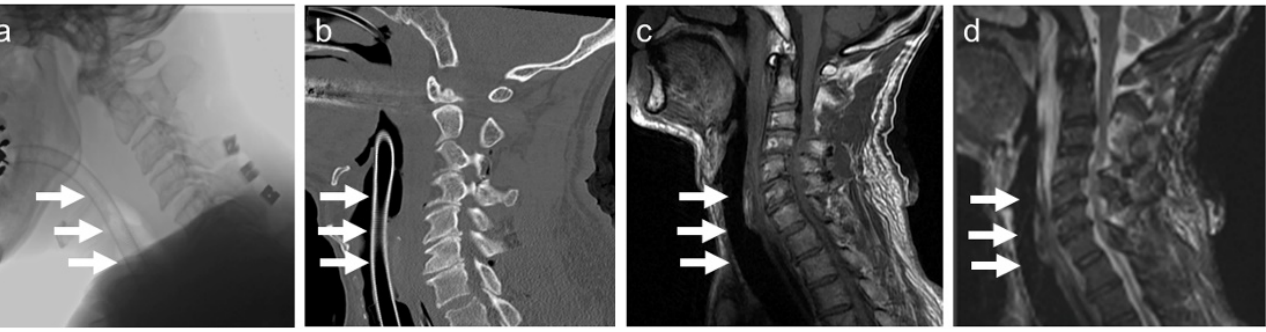
Figure 5. Clinical use of the Ti alloy helical wire-reinforced endotracheal tube (Ti-rET). ( a ) Radio- graphic image, ( b ) sagittal computed tomography image, ( c ) sagittal T1-weighted MR image, and ( d ) sagittal T2-weighted MR image. The white arrows show the intubated Ti-rET.